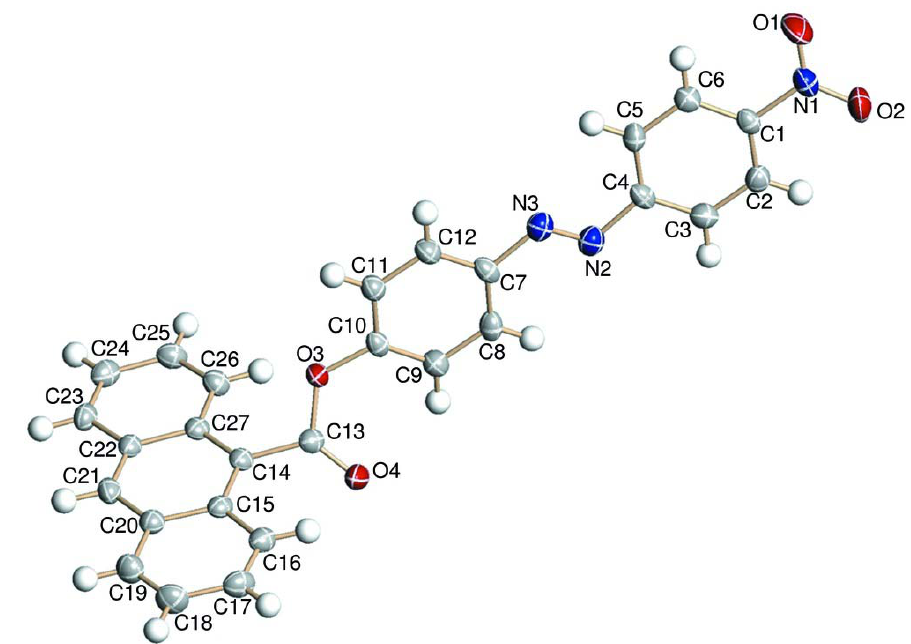
Figure 1 The molecular structure of (I) with 50% probability displacement ellipsoids for non-H atoms.